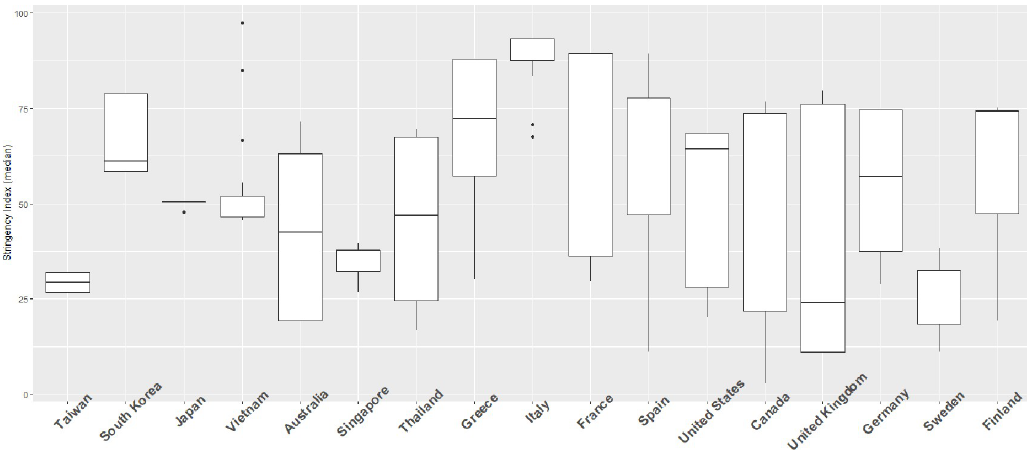
Fig 4. Box plots of stringency scores in 17